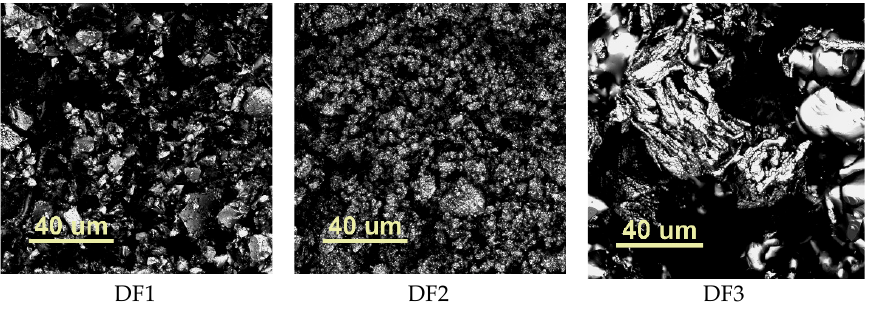
Figure 4. Images taken with a confocal optical microscope (COM). The scanned area was 129 μ m × 129 μ m (for the ×100 lens); abbrev: DF1—filler Ketac Fil Plus, DF2—Kromoglass 2 and DF3—i-FIX LC Light Curing Glass Ionomer Filling Cement.